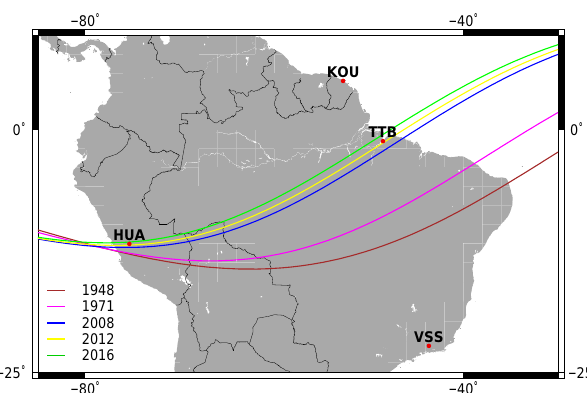
Figure 1. The location of the Tatuoca (TTB) observatory is shown along with INTERMAGNET observatories in the region (Kourou (KOU), Huancayo (HUA), and Vassouras (VSS)). In addition, the location of the geomagnetic equator according to IGRF is shown for different years between 1948 and 2016, as indicated by the